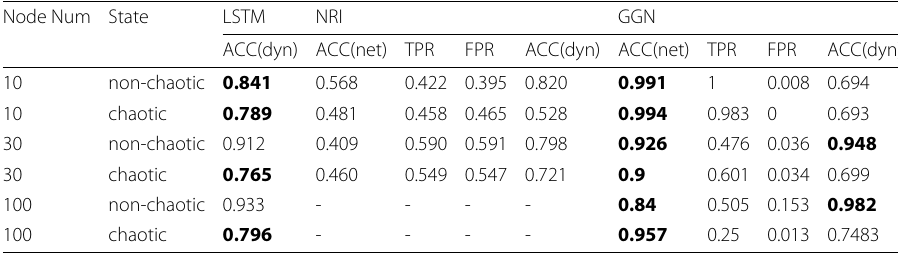
Table 1 Results with Boolean